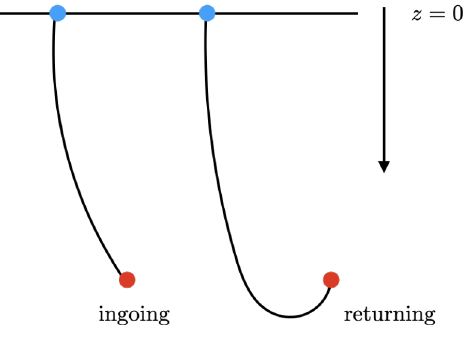
Figure 1 . The two types of geodesics to